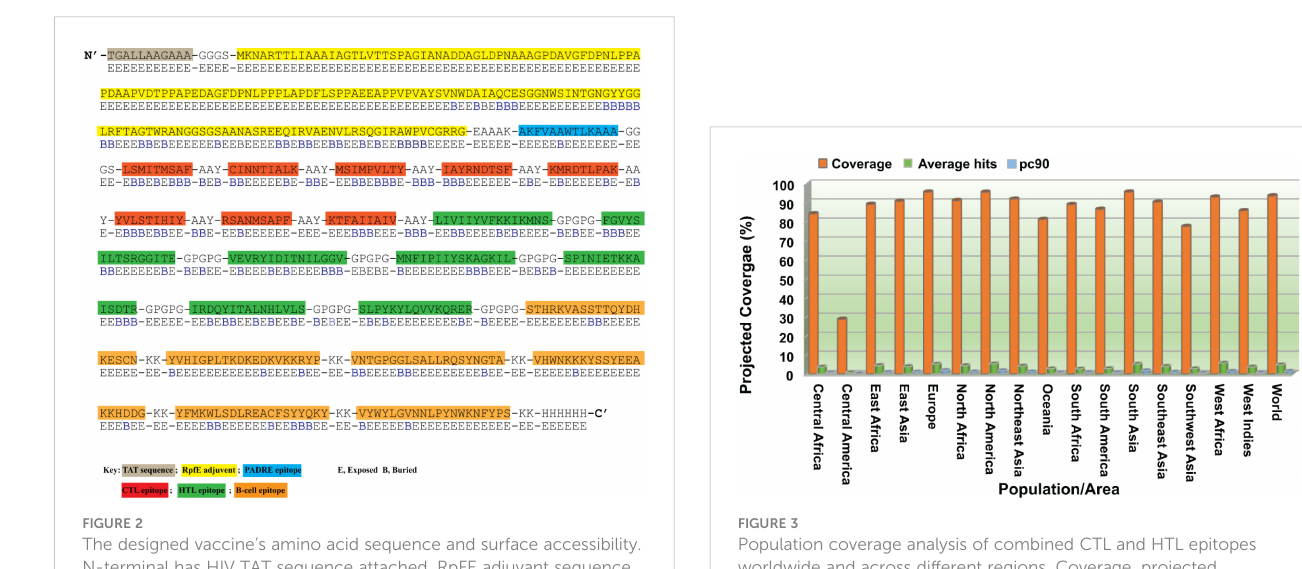
Underlined and bold letters are the similar fragments of peptides; Source organism of epitopes and the respective IEDB ID is also provided.